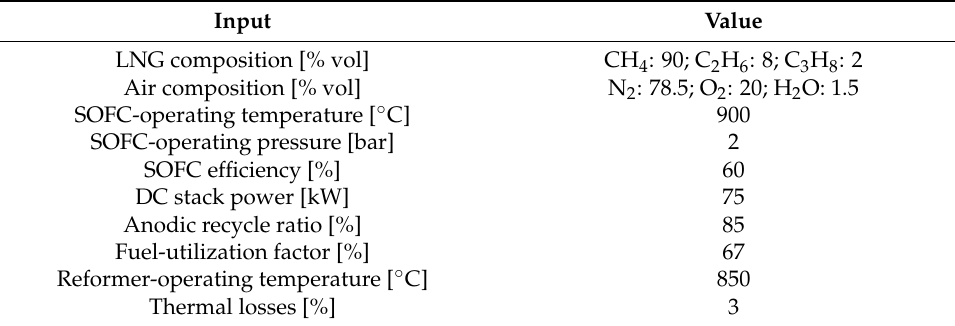
Table 2. SOFC power plant model input